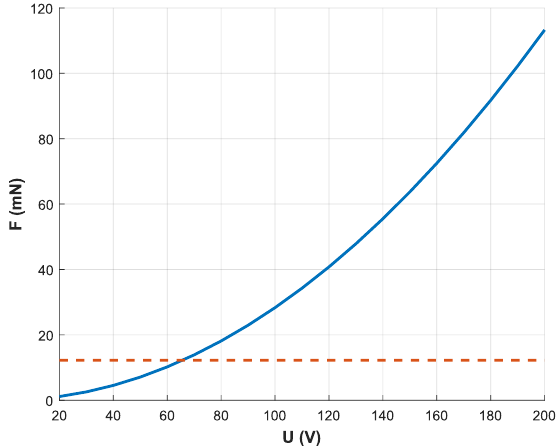
Figure 6. Force generated versus voltage considering a gap of x = 10 µ